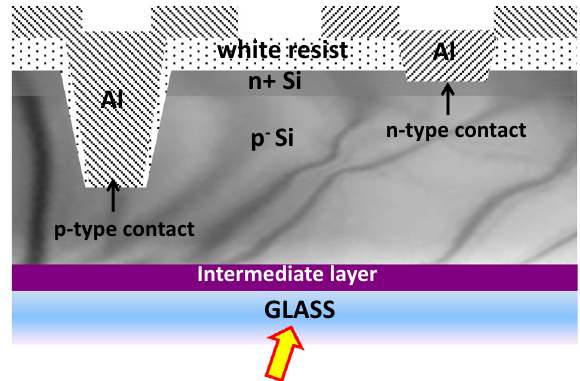
Fig. 4. The structure of a metallised solar cell. The light enters the cell through the front, glass